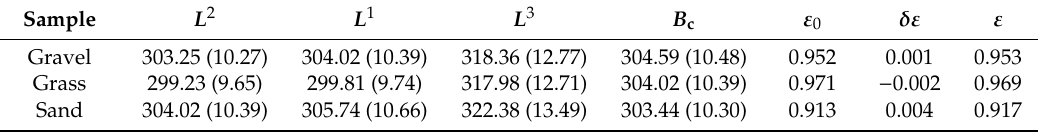
Table 3. Example values for the two-lid box measurements, with gravel, grass, and sand